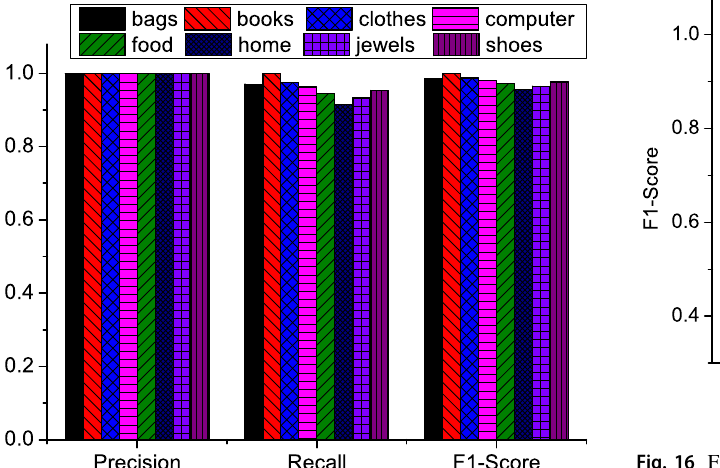
Fig. 16 F1-score comparison